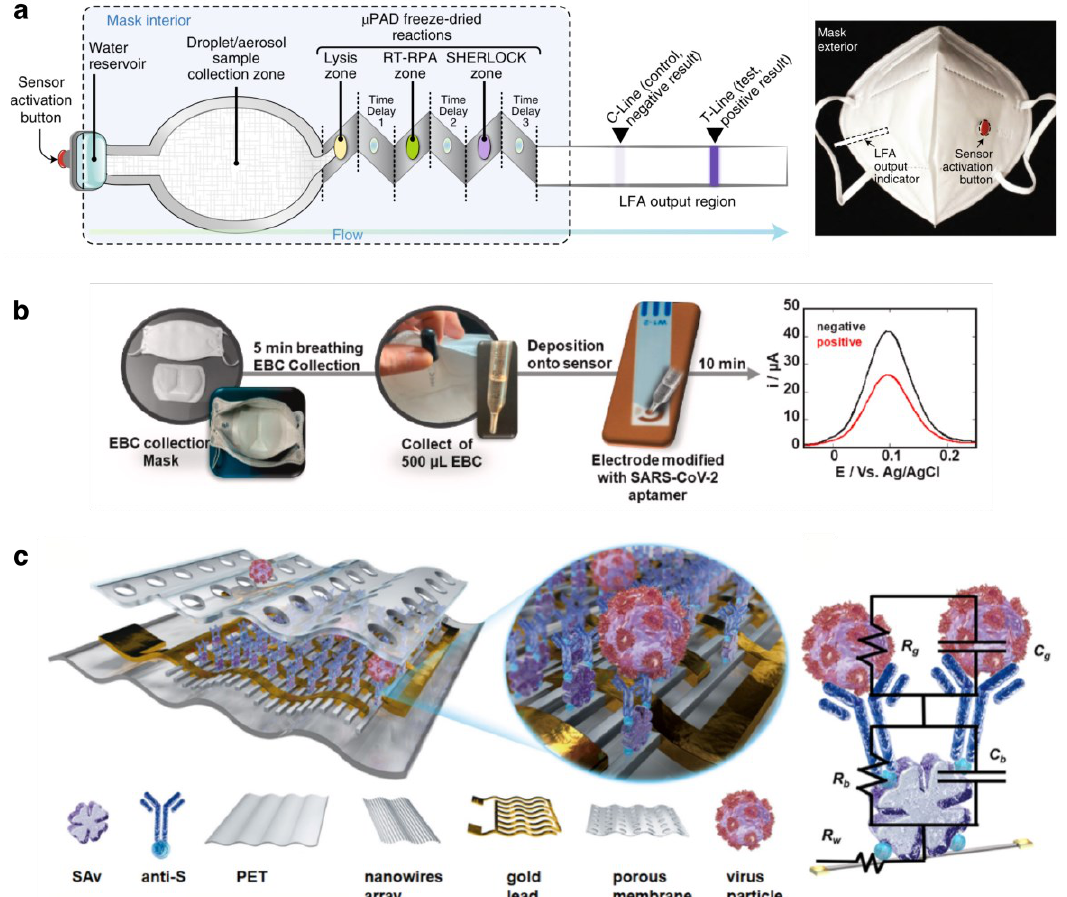
Figure 6. Mask-based COVID-19 diagnosis: ( a ) A face-mask-integrated sensor for SARS-CoV-2 detection in exhaled aerosols (Adapted and reproduced with permission from Ref. [140]. Copyright